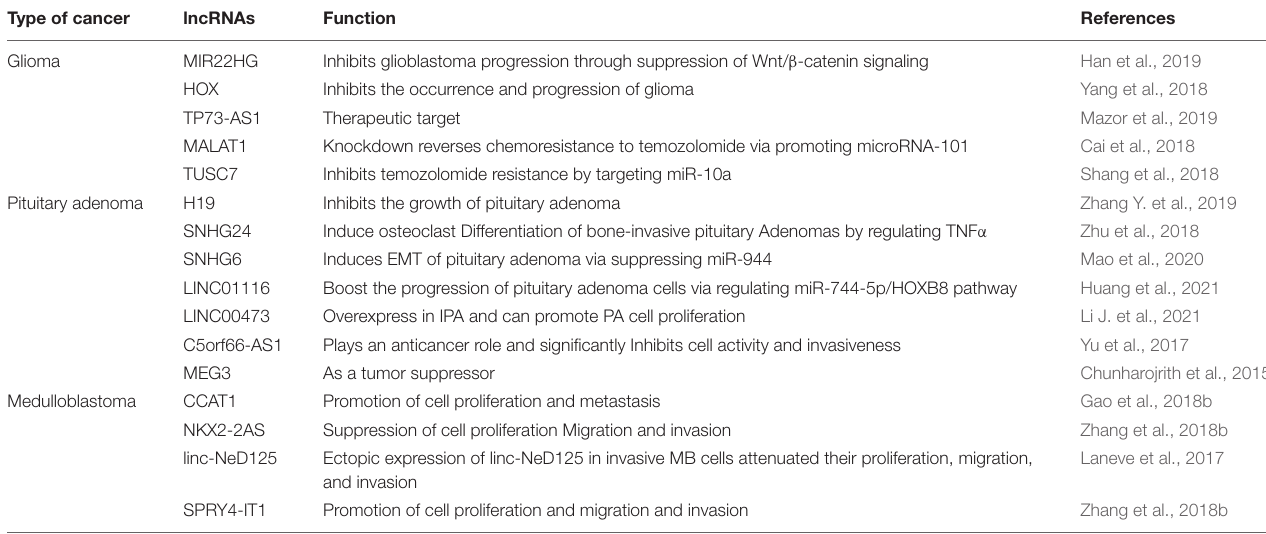
TABLE 2 | LncRNAs involved in the treatment of brain